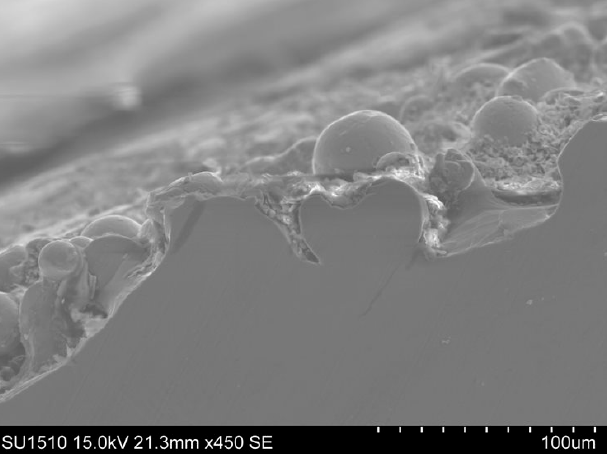
Figure 3. An electron microscopic cross-cut image of sample E1 , before burnishing. Figures 2 and 3 show the original surface of a sample before diamond burnishing. Partially molten dust particles are visible on the surface. The inequalities are 100 µm. In this sample, no pore defects can be detected at more than 100 µm from the surface.